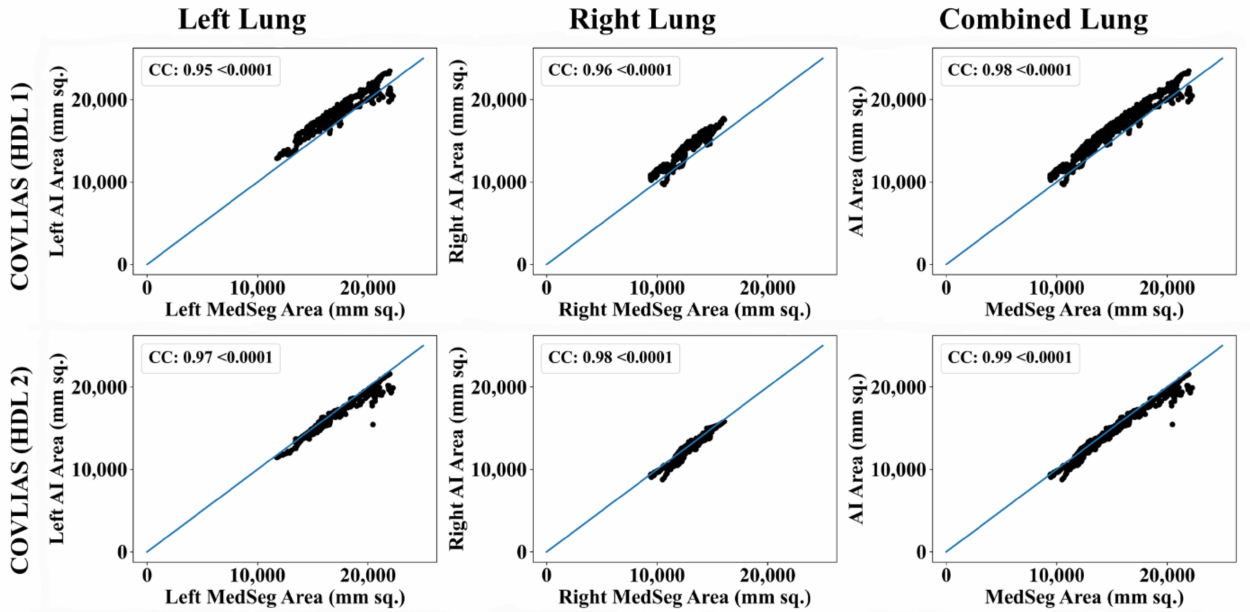
Figure 18. Bland–Altman plot: COVLIAS 1.0 vs. MedSeg. Left. Column 1: left lung, column 2: right lung, and column 3: combined lungs. COVLIAS (HDL 1): VGG-SegNet; COVLIAS (HDL 2): ResNet-SegNet.